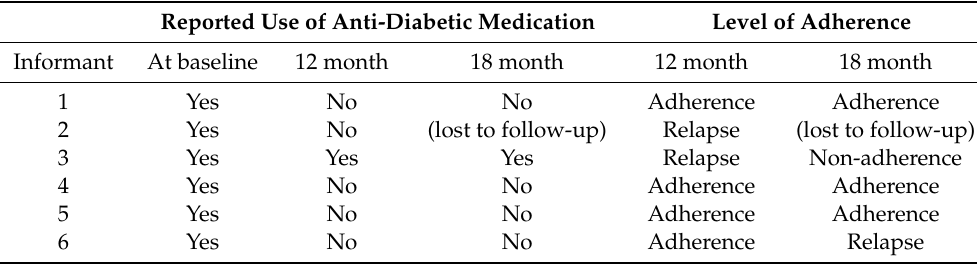
Table 4. Self-reported use of antidiabetic medication and level of adherence over